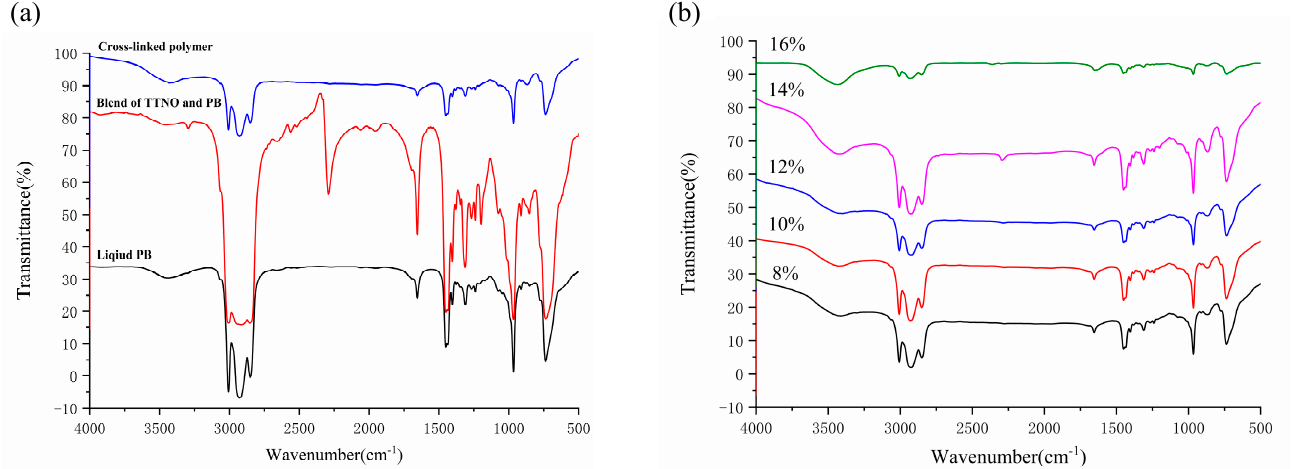
Figure 2. FT-IR spectra of ( a ) cross-linked polymer and the blend of PB and TTNO, ( b ) cross-linked polymers of different TTNO contents.